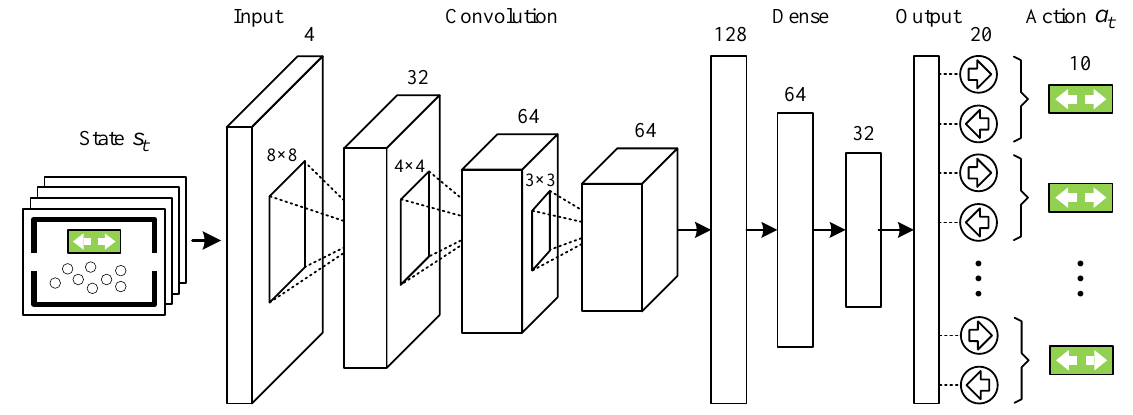
Figure 3. Network structure of combined action-space deep Q network